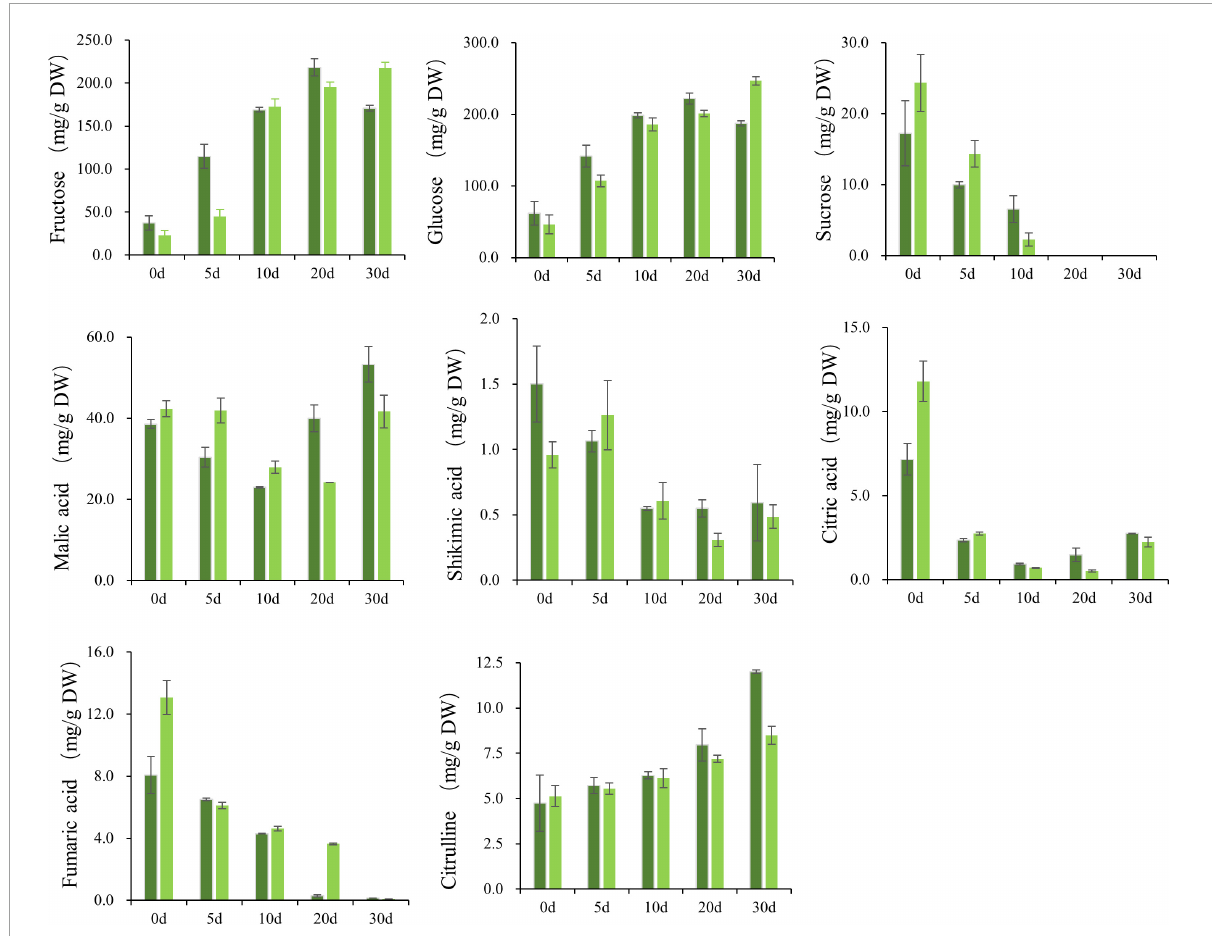
FIGURE2 Soluble sugars (glucose, sucrose, and fructose), organic acids (malic acid, fumaric acid, citric acid, and shikimic acid) and citrulline in wax gourd fruit at 0, 5, 10, 20, and 30 days after pollination between two specific significantly different varieties. Each value indicates mean ± standard deviation ( ± SD) values of three biological replicates. The concentrations were expressed in milligram per gram dry weight (DW). Dark green and light green represent B, G varieties with diverse genetic